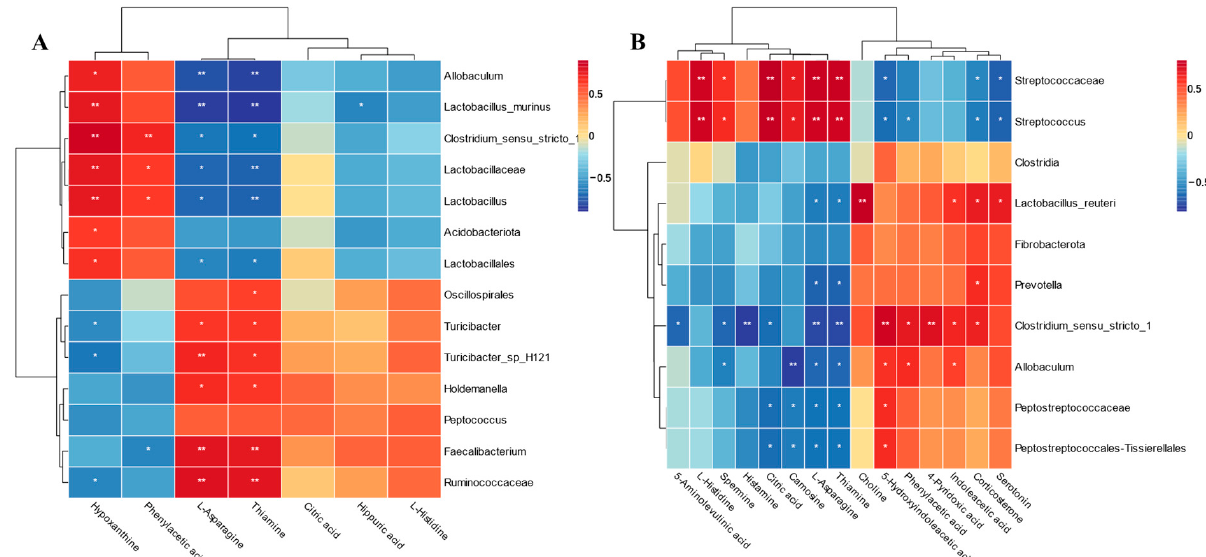
Figure 8. Spearman correlation analysis between the differential fecal metabolites and fecal microbiota in GT groups ( A ) and AC groups ( B ). GT groups, GT1 and GT2; AC groups, AC1 and AC2. GT1, before gradual transition, n = 6; GT2, after gradual transition, n = 6; AC1, before abrupt change, n = 7; AC2, after abrupt change, n = 7. * p < 0.05, ** p < 0.01 .